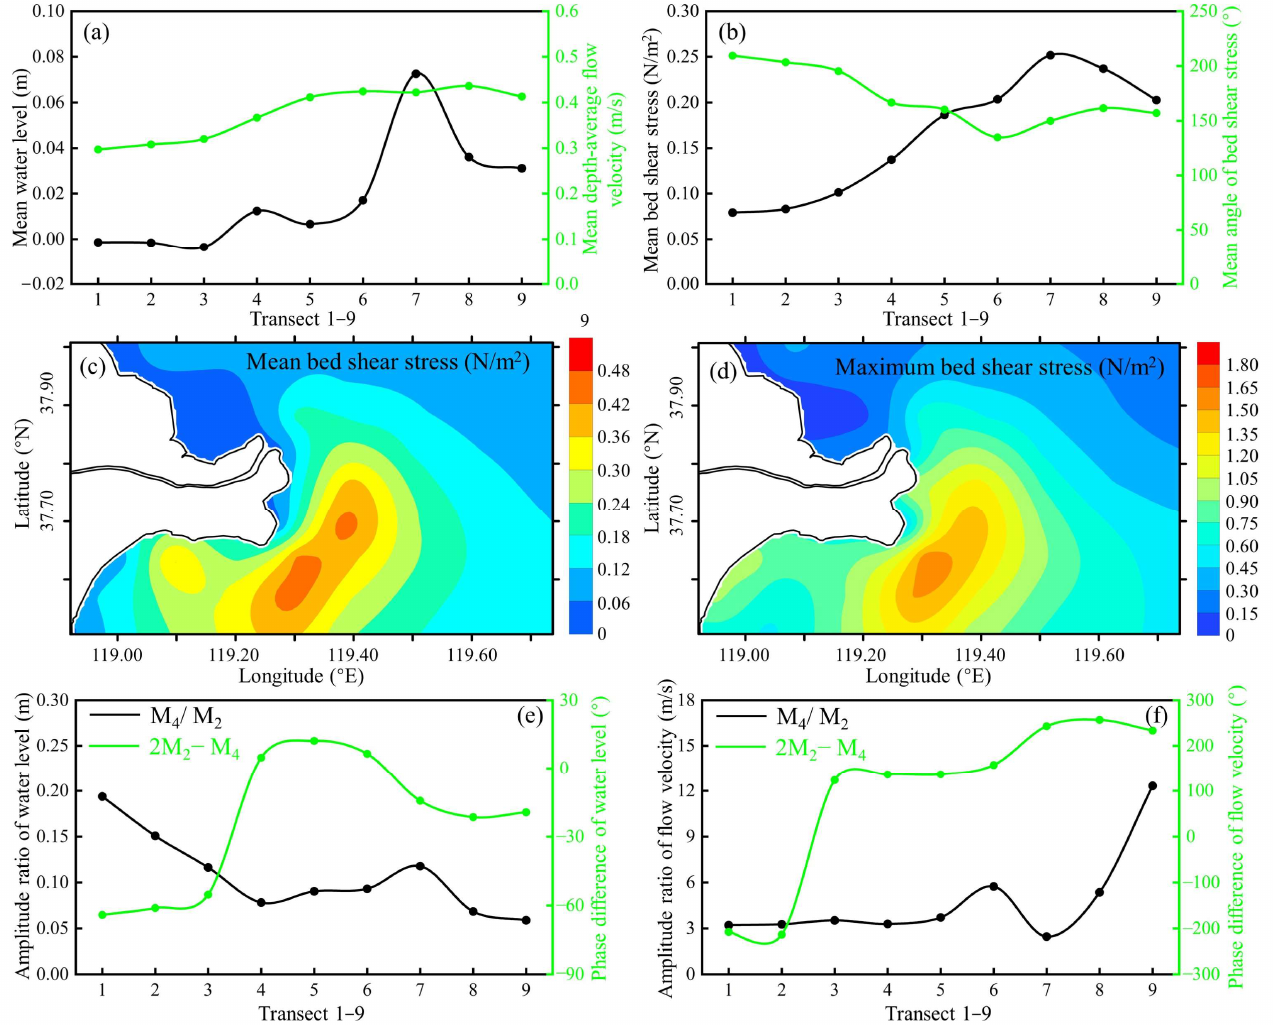
Figure 7. Q 1500 runoff scenario: modeled hydrodynamic results averaged over the 9 cross-sections in ( a ) mean water level and mean depth-averaged flow velocity, ( b ) mean bed shear stress and its angle. ( c , d ) Modeled mean and maximum bed shear stress in the YRD. ( e , f ) The amplitude ratio and phase difference of two constituents lead to tidal asymmetry.